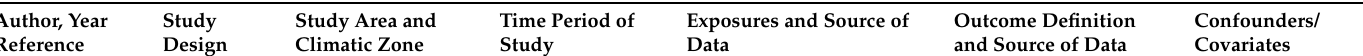
Table 2. Characteristics of included